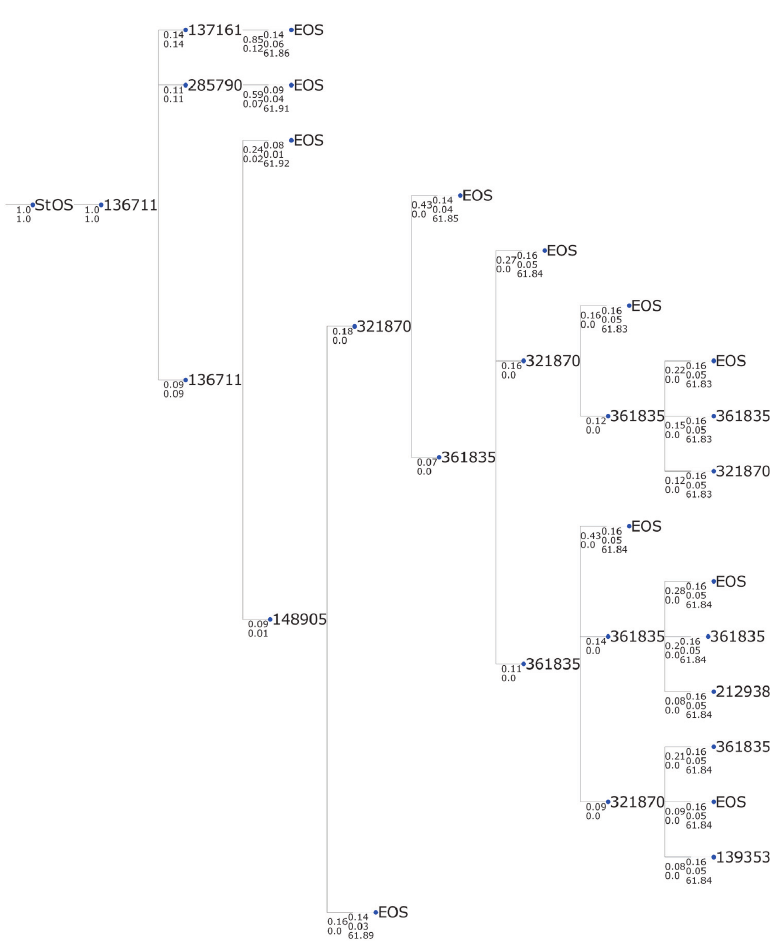
Figure 27: Output of the seq2probTree method for the HF production unit with input